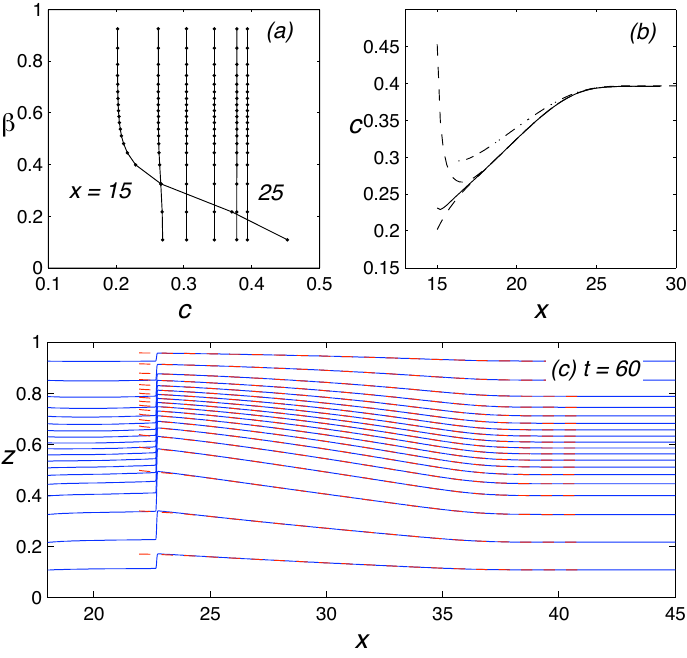
Fig. 9. (a) Speed c of interfacial points as a function of β at x = 15, 17, 19, 21, 23, and 25 computed from the numerical solution in Fig. 8 at t = 30. (b) Interfacial speed c as a function of x in the rarefaction region of the numerical solution at t = 30. The solid line shows the average and the dashed lines the maximum and minimum in β . The dash-dot line shows c(x) predicted from the weakly non-linear model (15) and the initial condition. (c) Close-up of the interface positions from the numerical solution in Fig. 8 at t = 60 (blue solid lines) and the prediction from assuming simple wave behavior from (30) with c(ξ) from (b) (red dashed lines).